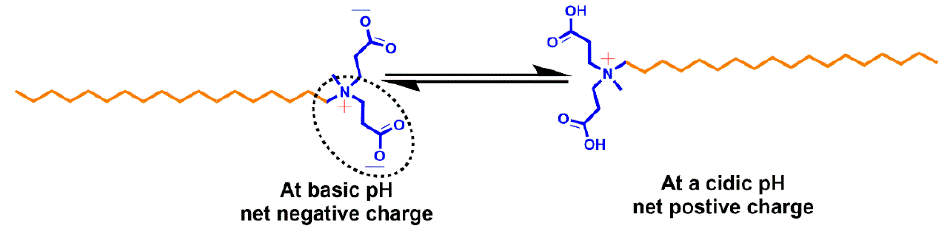
Table 1. MHD, PDI, ζ , DEE%, and DLC% of initial screening VCM-StAclm-Qt quatsomes. CHol: StBAclm (mg/mL) pH MHD (nm) PDI ζ (mV)